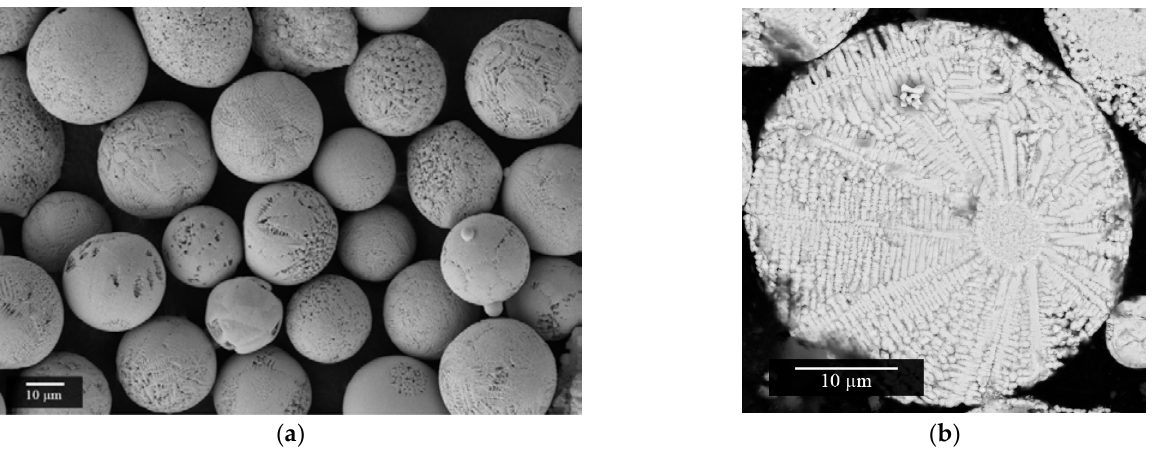
Figure 4. SEM images of BCZT powder after plasma spheroidization: ( a ) general view; ( b )